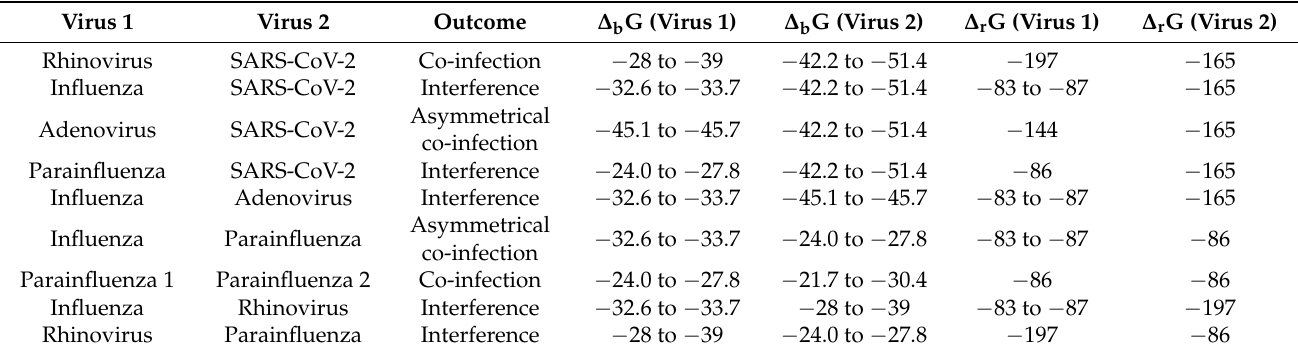
Table 4. Outcomes of virus competition, and their Gibbs energies of binding and growth. “Asymmetrical co-infection” is a situation where two viruses are simultaneously present in a multicellular host, but one virus is more numerous. ∆ b G and ∆ r G represent Gibbs energies of binding and growth,